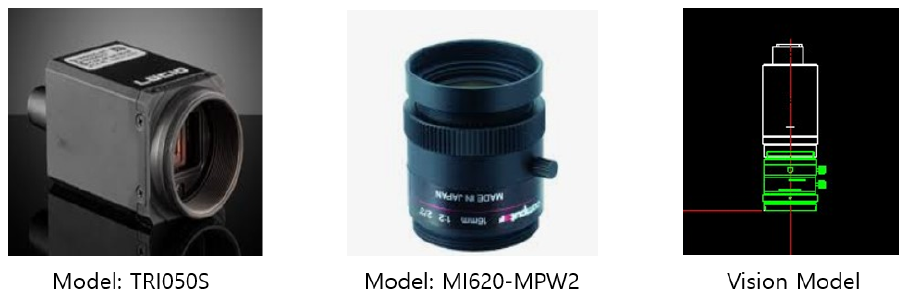
Figure 4. Vision Sensors used in Proposed System.